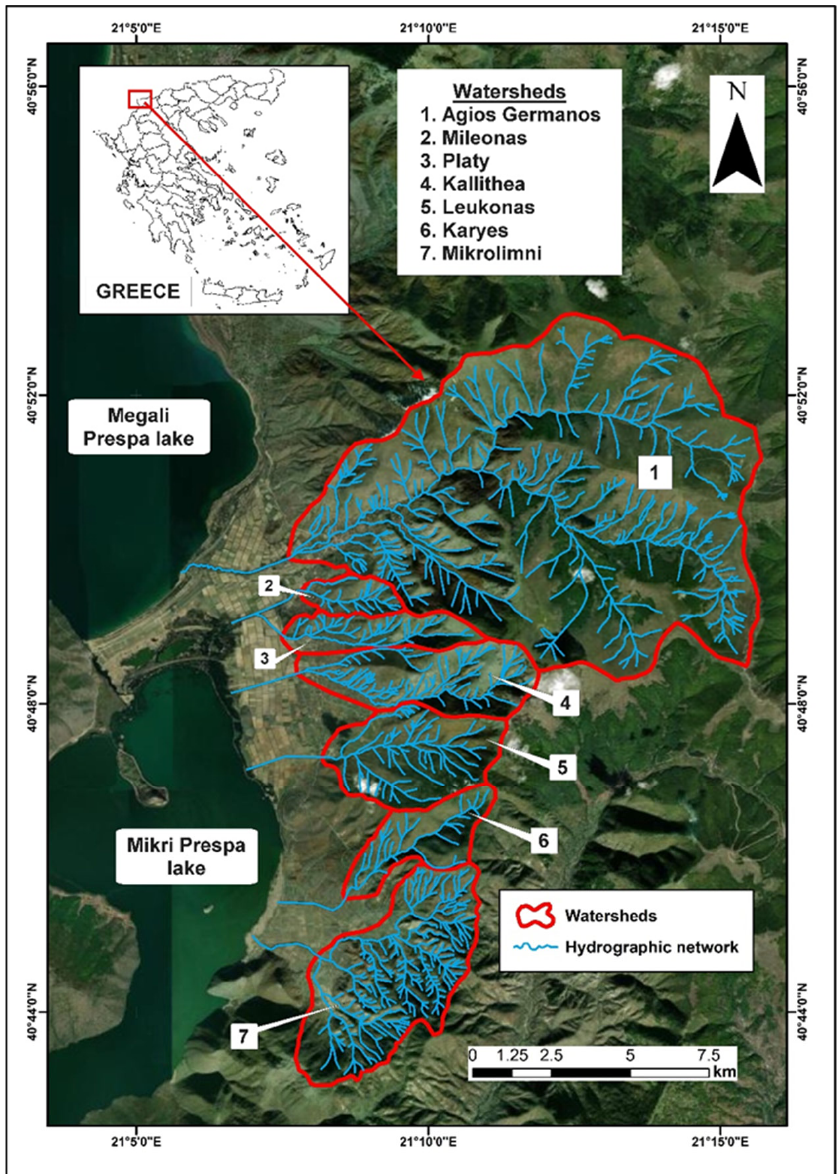
Figure 1. The watersheds that examined in the Greek part of Prespa Natural Park.